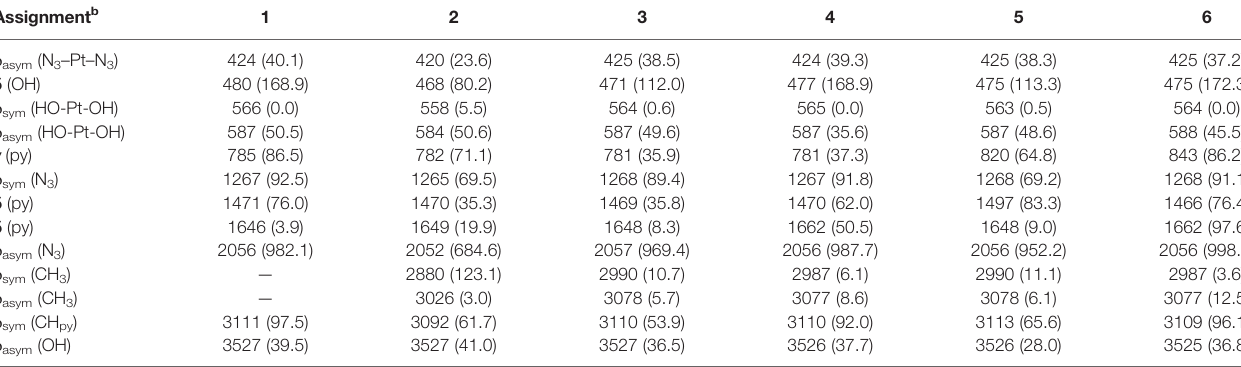
TABLE 3 | Frequencies(cm-1) and infrared intensitiesa(km/mol) calculated for compounds 1, 2, 3, 4, 5 and 6. Assignment